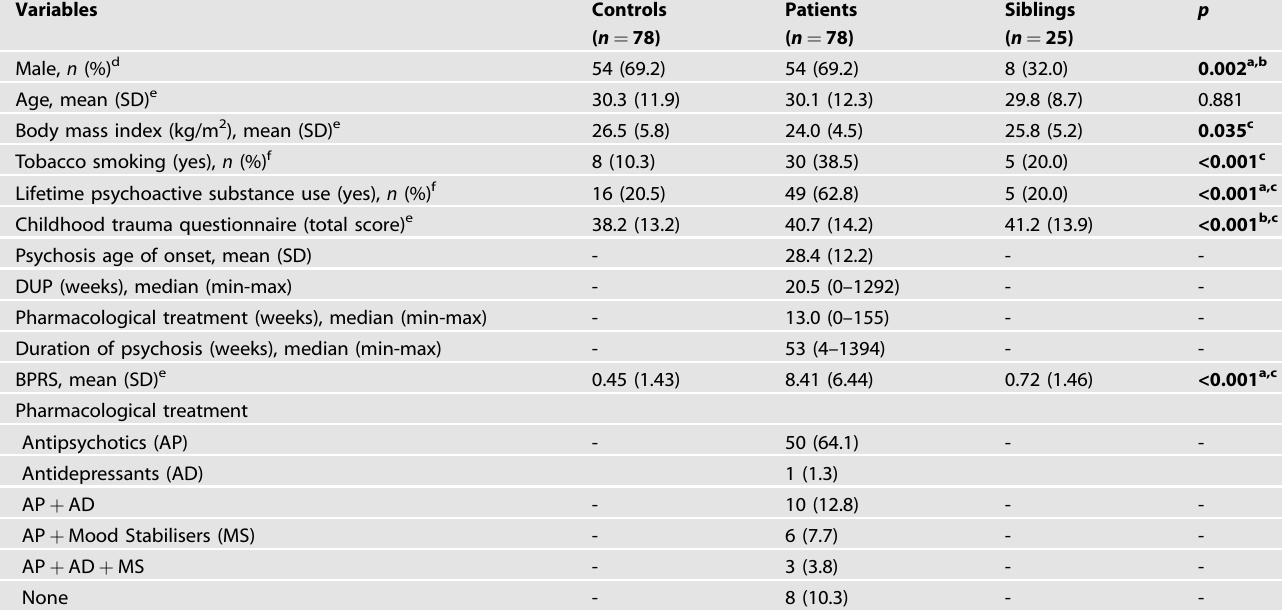
Table 1. Socio-demographic and clinical variables ( n =